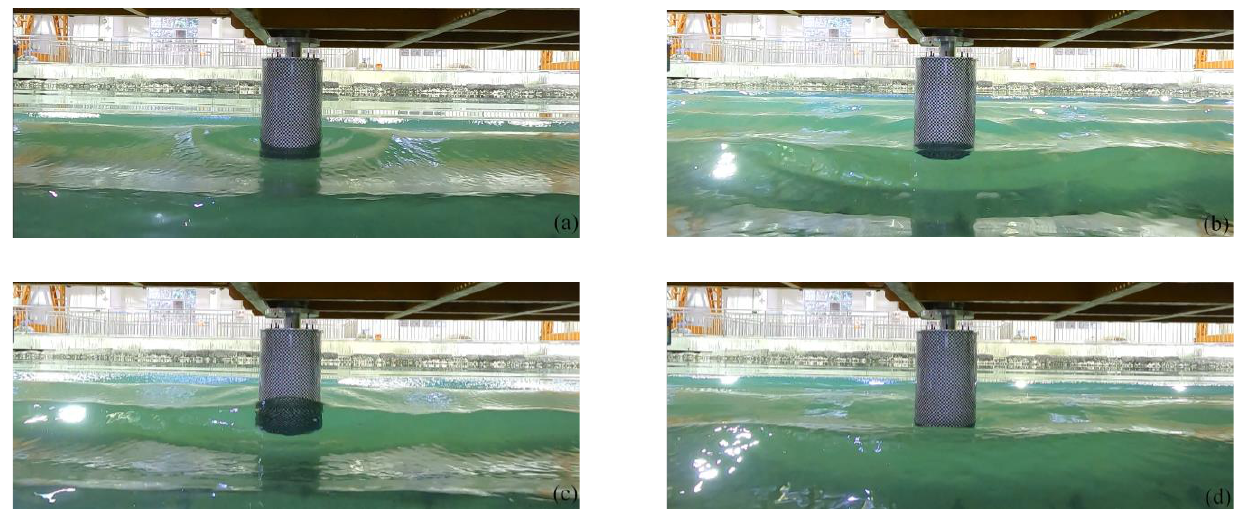
Figure 5. Process of wave interaction with the quasi-elliptical model at the moment of ( a ) diffraction wave generation, ( b ) diffraction wave and incident waves superimpose over one another, ( c ) the newly formed wave hits on the model and ( d ) the wave crest passes away.